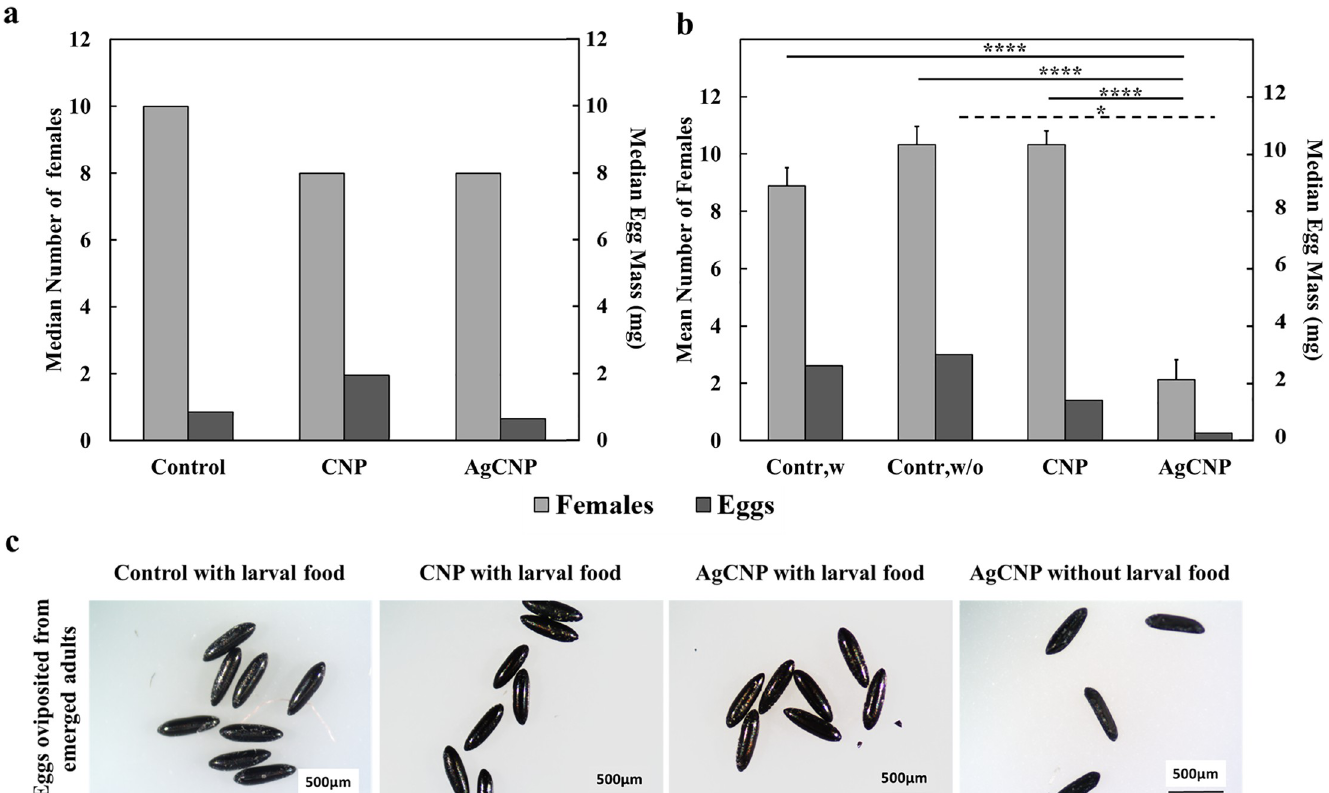
Fig 7. Effects on fecundity of nanoparticle-treated Ae . aegypti larvae. Third (3 rd ) instar larvae that were treated with nanoparticles in Fig 6 experiments were then allowed to emerge as adults and were given a blood meal five days post emergence; the resultant eggs were collected, weighed and characterized. ( a ) Median numbers of females emerged from nanoparticle-treated larvae with food in the rearing water ( Fig 6A ) and median egg masses produced from these females were not significantly different from control or each other. ( b ) When larval food was withheld for 48h following nanoparticle exposure ( Fig 6C ), there was a significant decrease in the mean number of females that emerged in the AgCNP group compared to both control and CNP-treated conditions (p-value < 0.0001). Correspondingly, the observed median egg mass in the AgCNP-treated condition was significantly lower compared to the food-withheld control group (p-value < 0.05). ( c ) Representative images of eggs from each group showed that eggs from the AgCNP-treated condition where larval food was withheld appeared collapsed in comparison (scale bar = 500 μ m). Contr,w: control, larval food present; Contr,w/o: control, larval food withheld. � : p-value < 0.05, ���� : p-value < 0.0001. Solid lines indicate significantly different comparisons between the mean number of females in different treatment groups. Dashed lines indicate significantly different comparisons between the median egg masses in different treatment groups. Error bars = SEM. Experiments for ( a ) were repeated twice with three (3) cups of females each, yielding six (6) cups in total for each experimental condition. Experiments for ( b ) were repeated three (3) times with three (3) cups of females each, yielding nine (9) cups in total for each experimental condition.